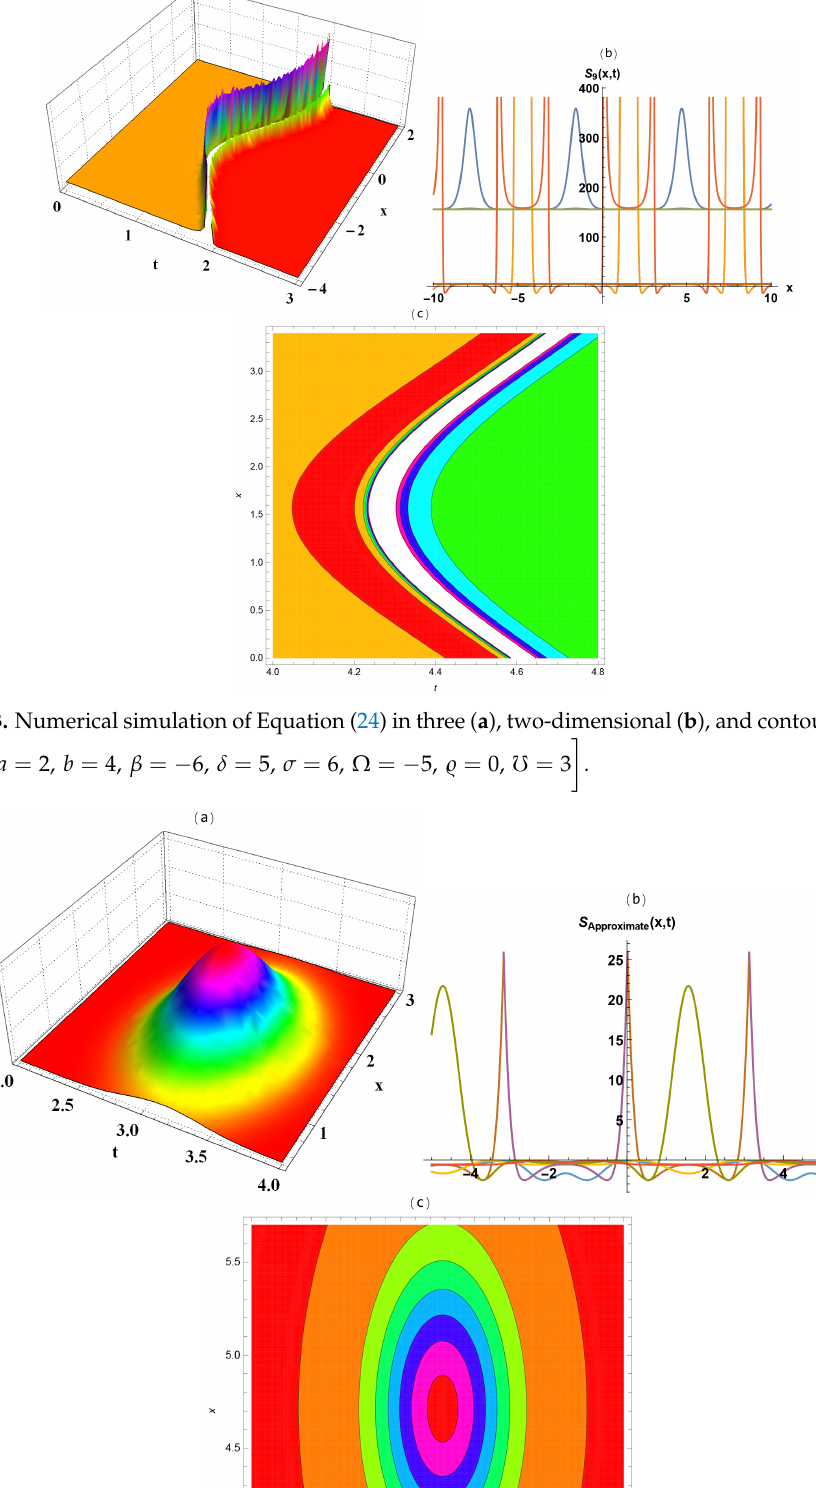
Figure 4. Numerical simulation of Equation (30) in three ( a ), two-dimensional ( b ), and contour sketches ( c